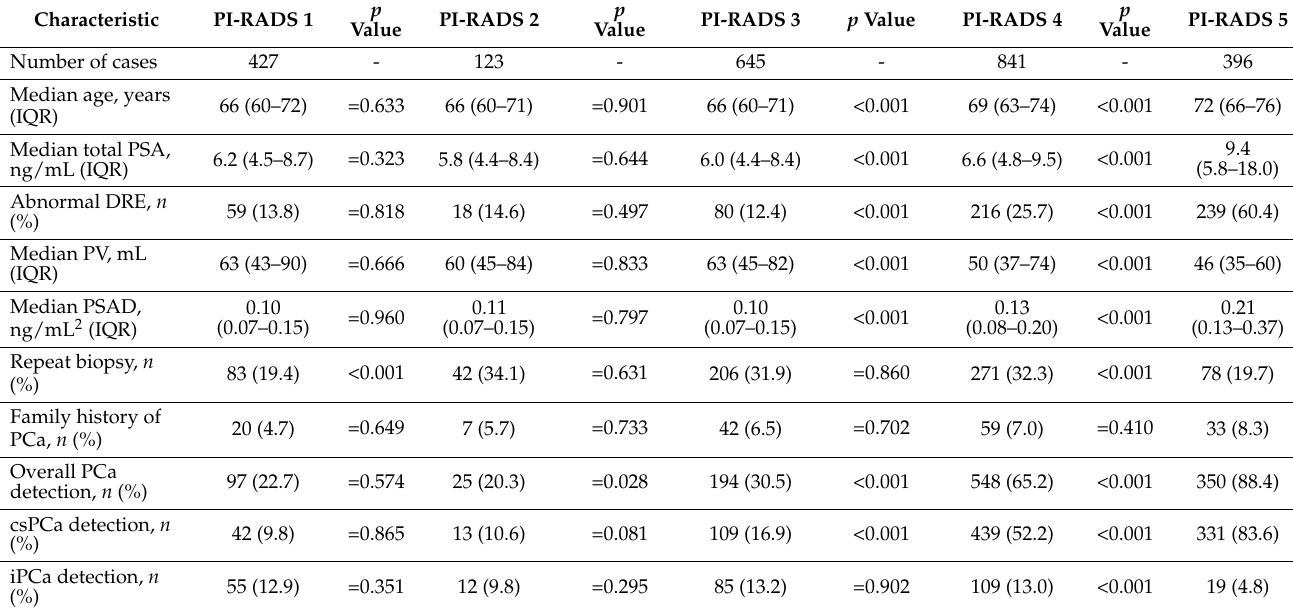
Table 2. Characteristics of study population according to the PI-RADS